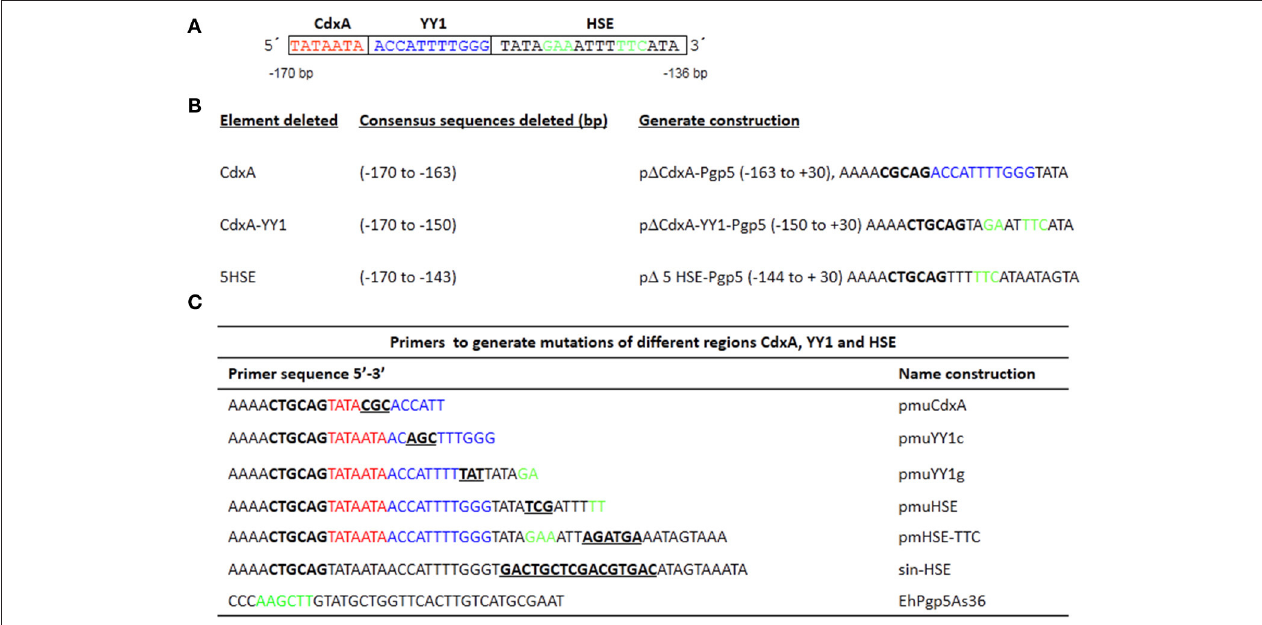
FIGURE 1 | Plasmid constructions in the EhPgp5 gene core promoter. (A) Schematic representation of three consensus sequences in the EhPgp5 gene promoter ( − 170 to − 136 bp). CdxA, YY1, and HSE motifs are marked in red, blue, and green in the rectangles, respectively. (B) Constructs generated by deletion of each consensus sequence of the EhPgp5 gene core promoter ( − 170 to − 136 bp). (C) Primers used to generate different mutations in CdxA, YY1, and HSE motifs. Mutations are underlined and bolded in black. Restriction sites for Pst I and Hind III are bolded in black. The last sequence is the antisense primer used for all